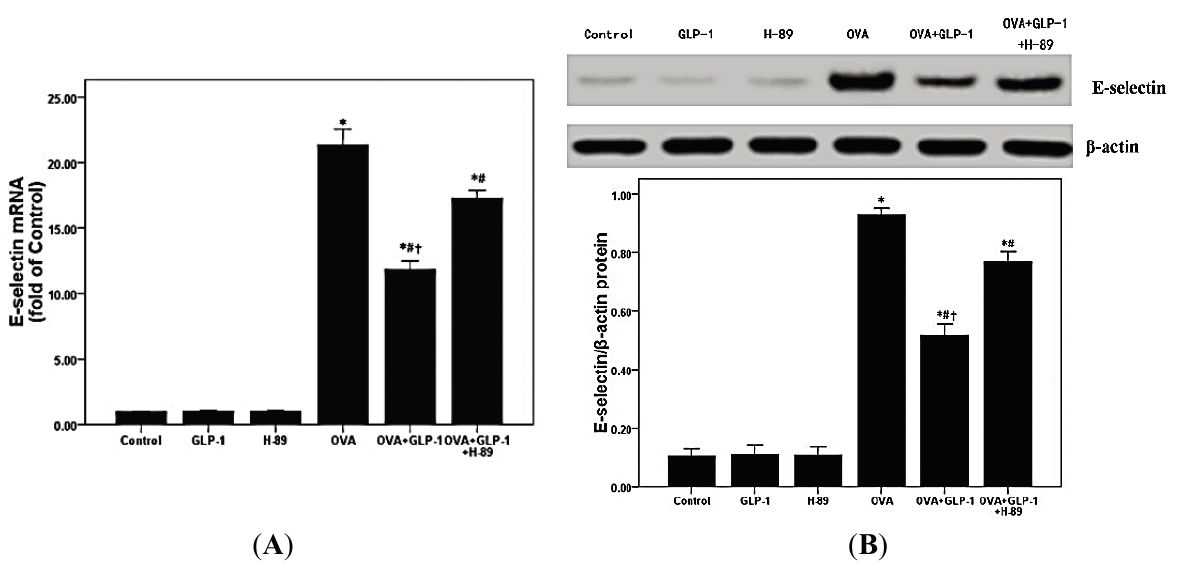
Figure 3. GLP-1 down-regulates E-selectin in the lung tissues in OVA-induced chronic asthma. ( A ) qPCR was used to measure E-selectin mRNA expression in lung; ( B ) Western blotting was performed to measure E-selectin protein expression in lung. Each bar represents the mean ± SD of 10 mice. * p < 0.05 compared with control. # p < 0.05 compared with OVA. † p < 0.05 compared with OVA + GLP-1 +